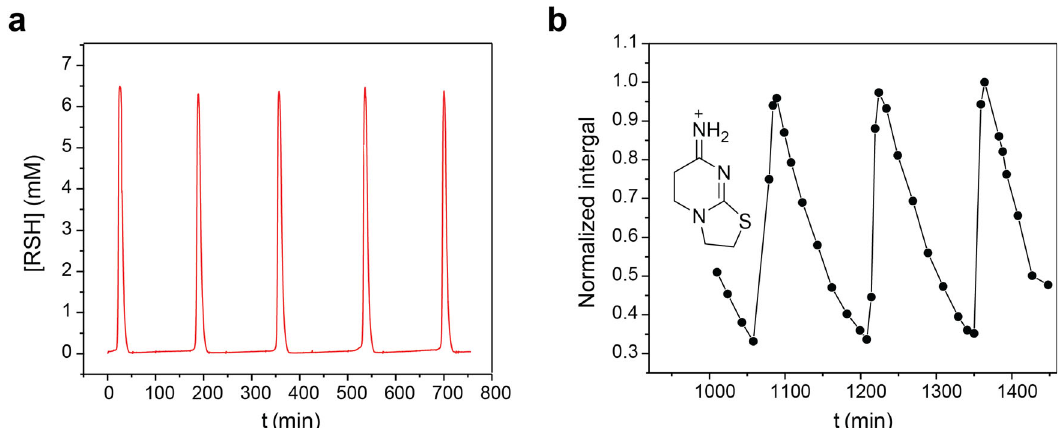
Fig. 7 Kinetic studies of the thiouronium salt-based oscillator that uses disul fi de 18. Experimental conditions: H 2 O, 1 M PB pH 8, at 40 °C; [ 8 ] = 56 mM; [ 18 ] = 56 mM; [Maleimide] = 8 mM; [Acrylamide] = 112 mM; f / V = 1.61 × 10 − 4 s − 1 . a Experimental data showing sustained oscillations in the concentration of thiols. b Experimental data showing relative changes in the amount of 22 in CSTR. Points show normalized integrals of the HPLC peak (4.4 min, SILEC Primeser 500 4.6 × 250mm, H 2 O (0.1% TFA)/CH 3 CN) corresponding to 22 obtained by analysis of the drops that come from CSTR. The detection was performed by MS detector set to m / z = +